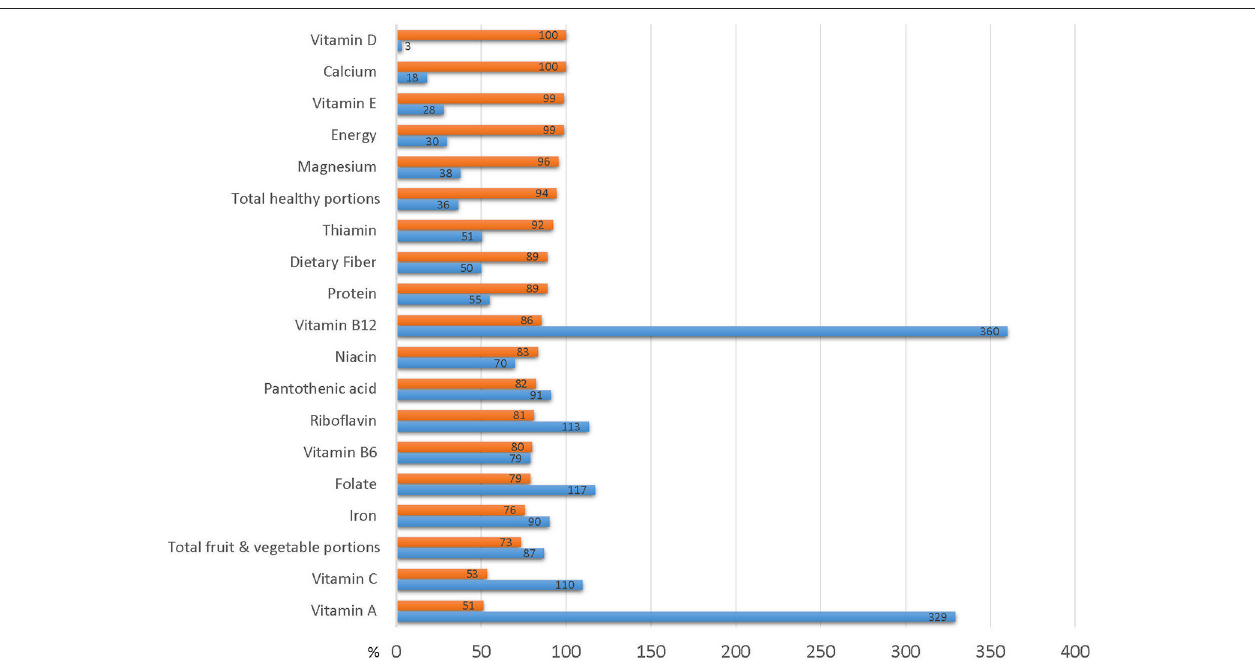
TABLE 6 | The contribution of food provided by the Leket Israel food bank to the nutrient content of the food pantries’ aid baskets. Nutrient Total weighted mean